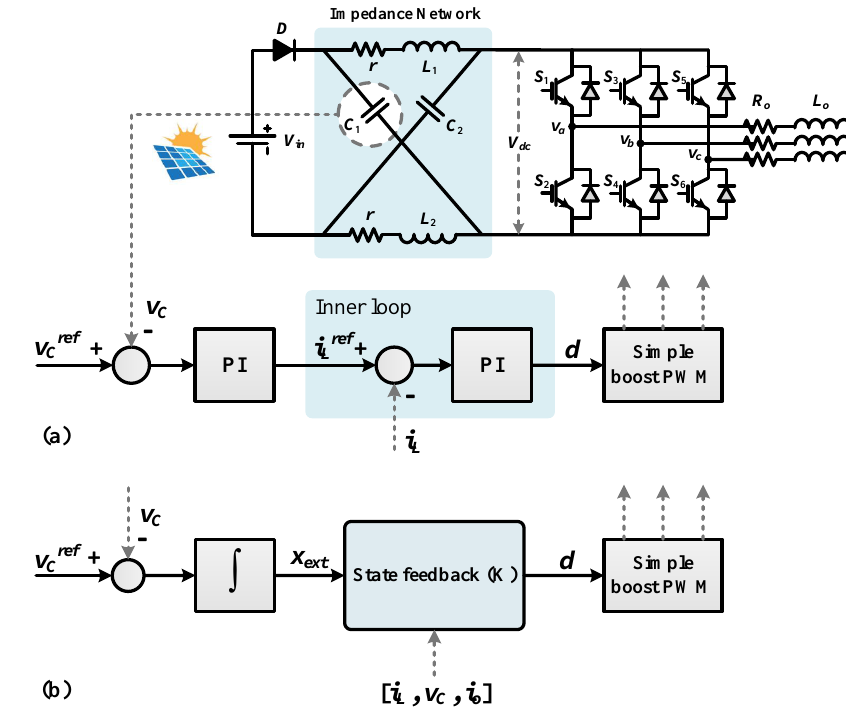
Figure 3. Dual loop control of a ZSI ( a ) with PI controller and ( b ) with state feedback (SF)